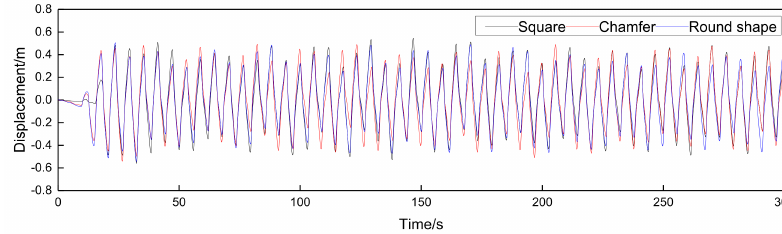
Figure 5. Device’s lateral movement trajectory.